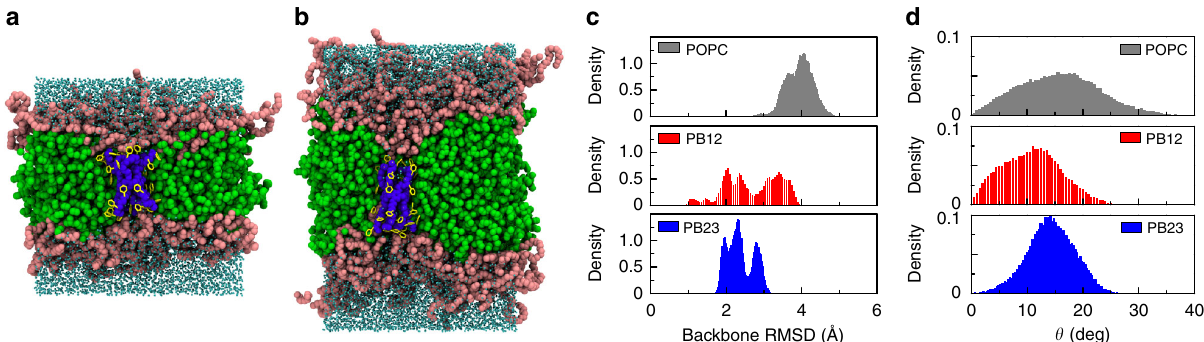
Fig. 3 MD simulations of PAP channels in bilayers demonstrate adaptation to PAP length, and unique restraining effects of polymers. Snapshots of single PAP channel conformation in PB 12 -PEO 9 ( a ) and PB 23 -PEO 16 ( b ) bilayer membranes at t = 200 ns in each MD simulation. The hydrophobic PB chains are shown in green and the hydrophilic PEO chains are shown in pink spheres. The water molecules are cyan. The PAP channel backbone is blue with yellow aromatic rings on the side chains. c The root-mean-squared-deviation (RMSD, with respect to its initial conformation) of the PAP channel backbone in POPC membranes was larger than that in either PB12 or PB23 membranes. The smaller RMSD value for PB polymers suggested that the channel ’ s ‘ peptide- arm ’ movements were more constrained in block copolymer membranes. d The averaged angle orientation during the simulation showed that the PAP channel (an angle of 0° indicates a conformation perpendicular to the membrane surface and an angle of 90° indicates a conformation parallel to the membrane surface) preferred to keep an averaged angle of ~ 15° in three types of the membranes. The broader angle distribution in POPC membranes indicated that PAP channels were more fl exible with more peptide-arm movement fl exibility in lipid membranes than in PB-PEO membranes. Data shown are averages over triplicate